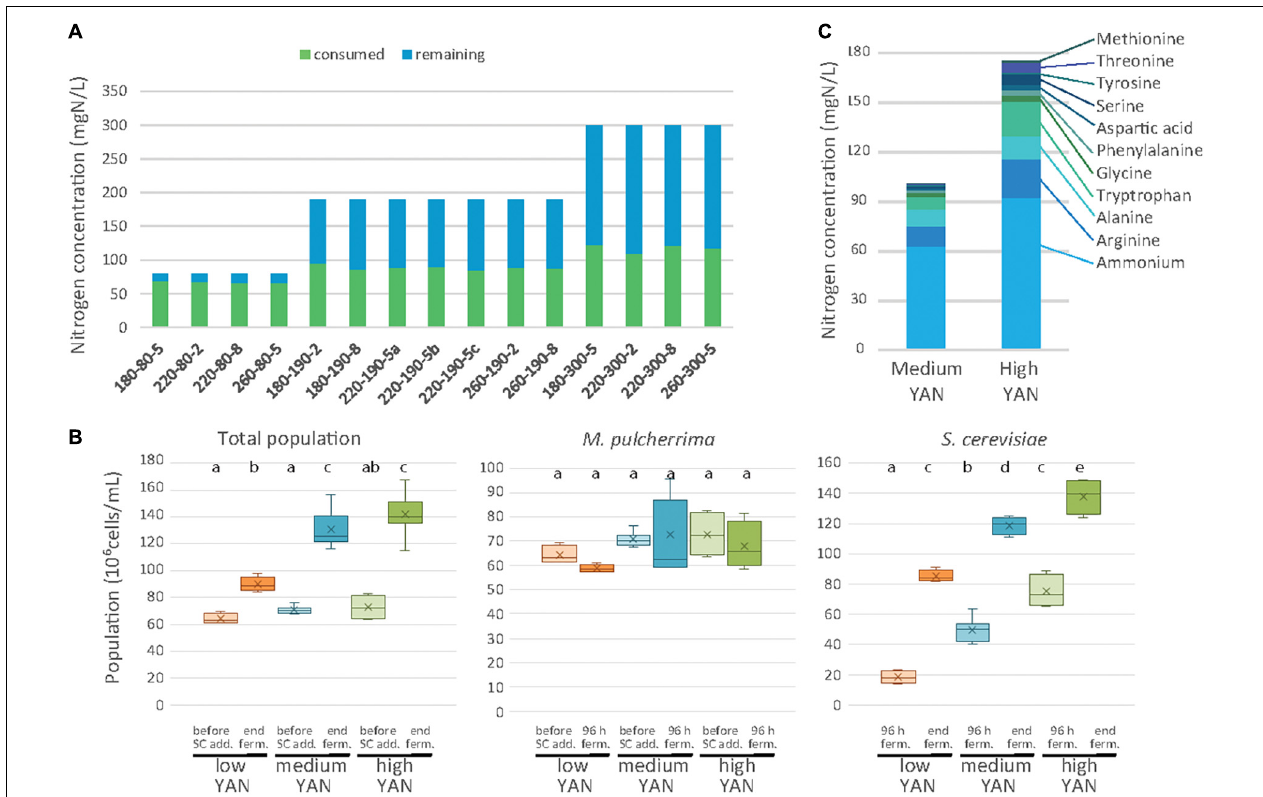
FIGURE 2 | Nitrogen consumption and cell populations during sequential fermentations. (A) Concentrations of consumed (blue bars) and residual (green bars) assimilable nitrogen after 48 h of fermentation with M. pulcherrima , depending on the conditions. Conditions are labeled as sugar-nitrogen-lipids. (B) Total cell population, M. pulcherrima population and S. cerevisiae population depending on the nitrogen availability (low: orange, medium: blue, high: green) at different stages of fermentation. (C) Composition of the nitrogen resource after 48 h of M. pulcherrima f ermentation in presence of medium or high YAN concentration.